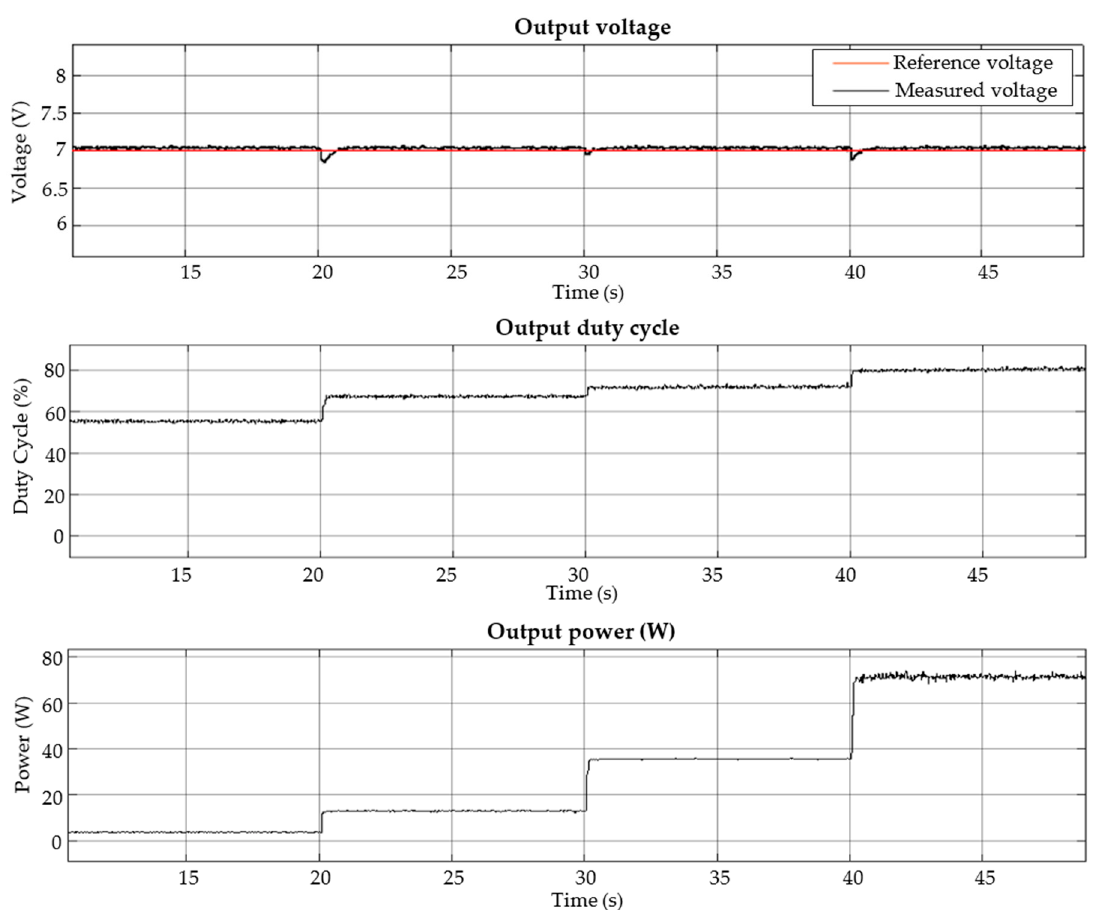
Figure 11. Output voltage response of the fuzzy logic controlled buck converter as the load power is stepped.